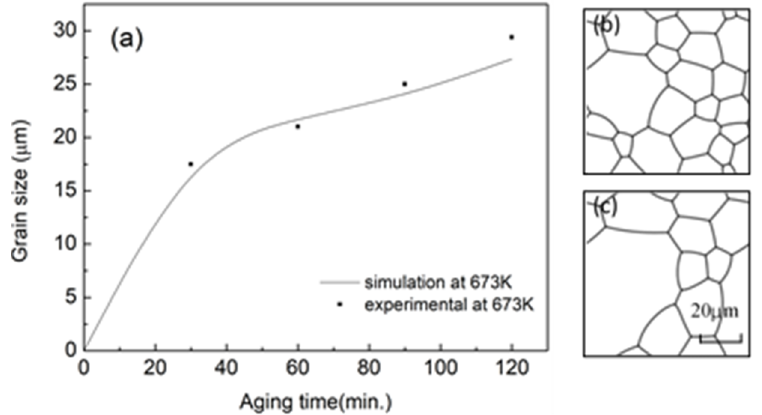
Figure 2. ( a ) The comparison of grain size; ( b , c ) simulation microstructure at 30 min and 120 min, respectively.